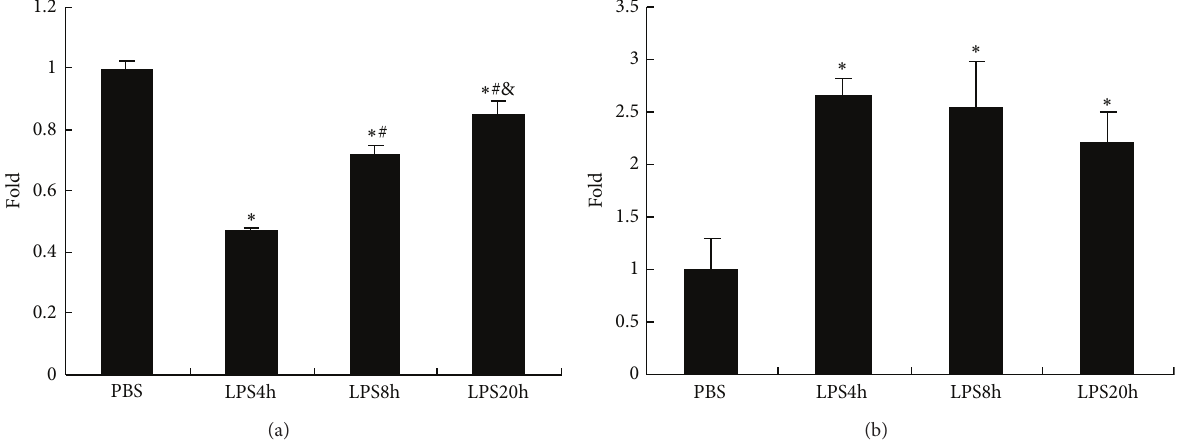
Figure 2: LPS stimulation reduced ACh release and upregulated 𝛼 7nAChR expression of RAW264.7 cells. (a) ACh secretion in the supernatant of RAW264.7 cells incubated with LPS (100ng/mL). ACh secretion decreased from RAW264.7 cells challenged with LPS for 4 h and then gradually recovered along with the LPS incubated time. (b) The rate of 𝛼 7nAChR positive cells was increased in LPS